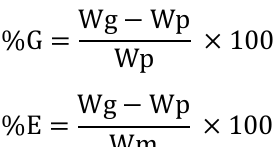
Table 2. Descriptive statistic of initiator concentration on grafting parameters [Fe 2+ ] [H + ] [PMS] Parameters Percentage Percentage Percentage (×10-3 mol/dm3 (×10-3 mol/dm3 (×10-3 mol/dm3 ) ) ) 2.0 84.0 ± 1.00 (b) Percentage of grafting (%G) 2.0 Percentage of grafting efficiency (%E) F 296.157 P < 0.001 < 0.001 < 0.001 Means, within each column, followed by the same letter(s) are not significantly different at the 0.05 probability; level using Duncan's Multiple Range